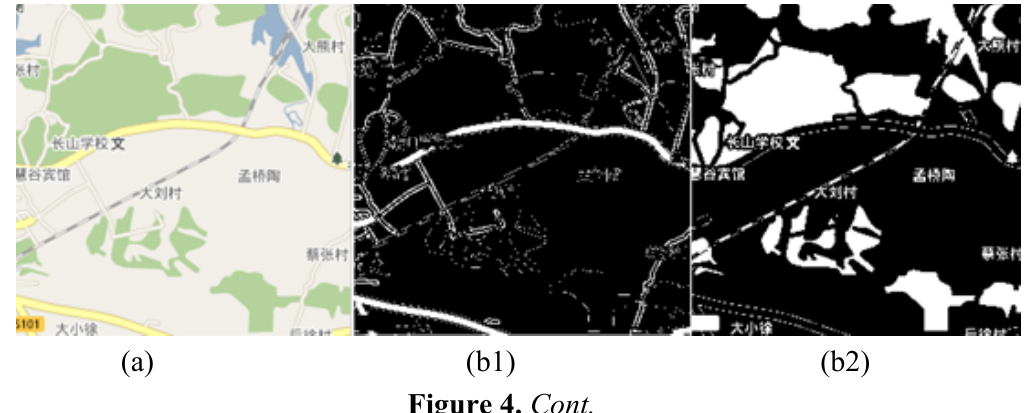
Figure 3. The segmentation result of “map1” image: (a) “map1” original image; (b1) “road” of KFCM_F; (b2) “lake” of KFCM_F; (c1) “road” of FCM_S; (c2) “lake” of FCM_S; (d1) “road” of the proposed method; (d2) “terrain” of the proposed method; (d3) “lake” of the proposed